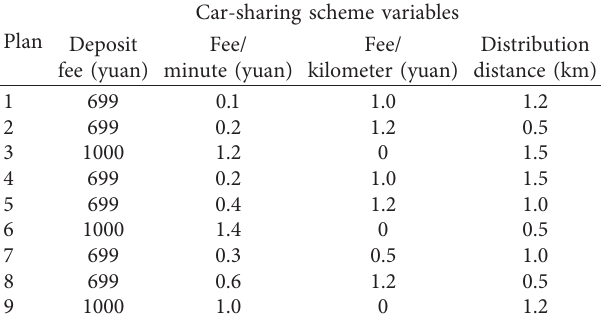
Table 2: Car-sharing